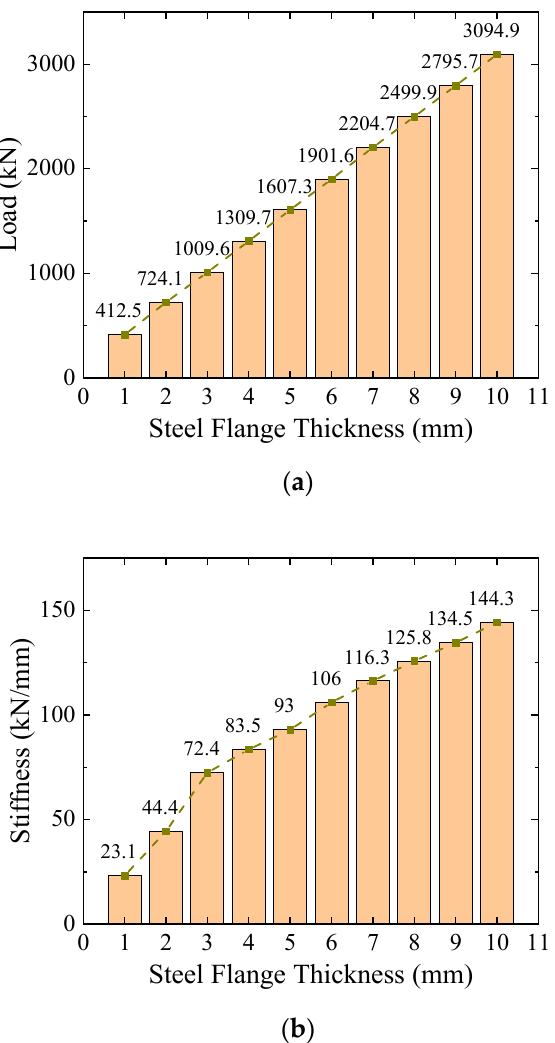
Figure 19. Influence of steel flange thickness on flexural behavior. ( a ) Influence of steel flange thickness on load-carrying capacity; ( b ) influence of steel flange thickness on initial stiffness.